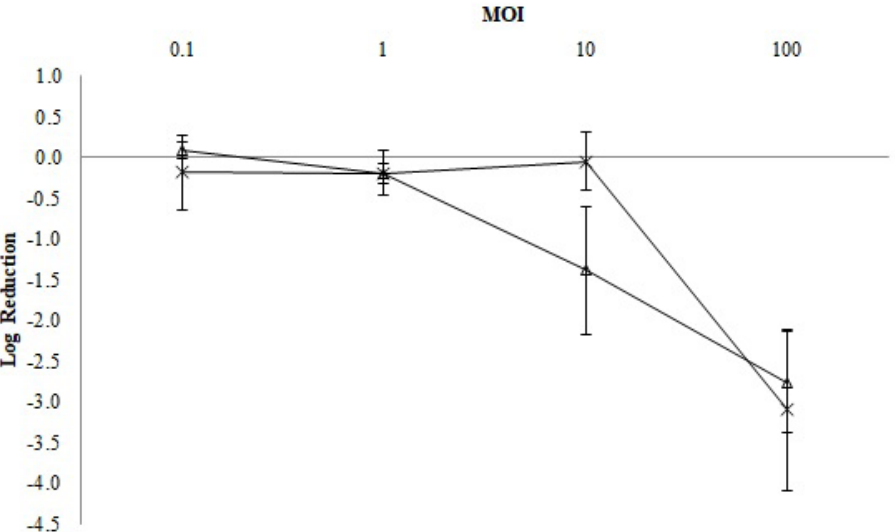
Figure 2: Log reduction of B . cereus TISTR 687 with different multiplicities of infection (MOIs) of bacteriophage BaceFT01 (Δ) and BaceCM02 (×).